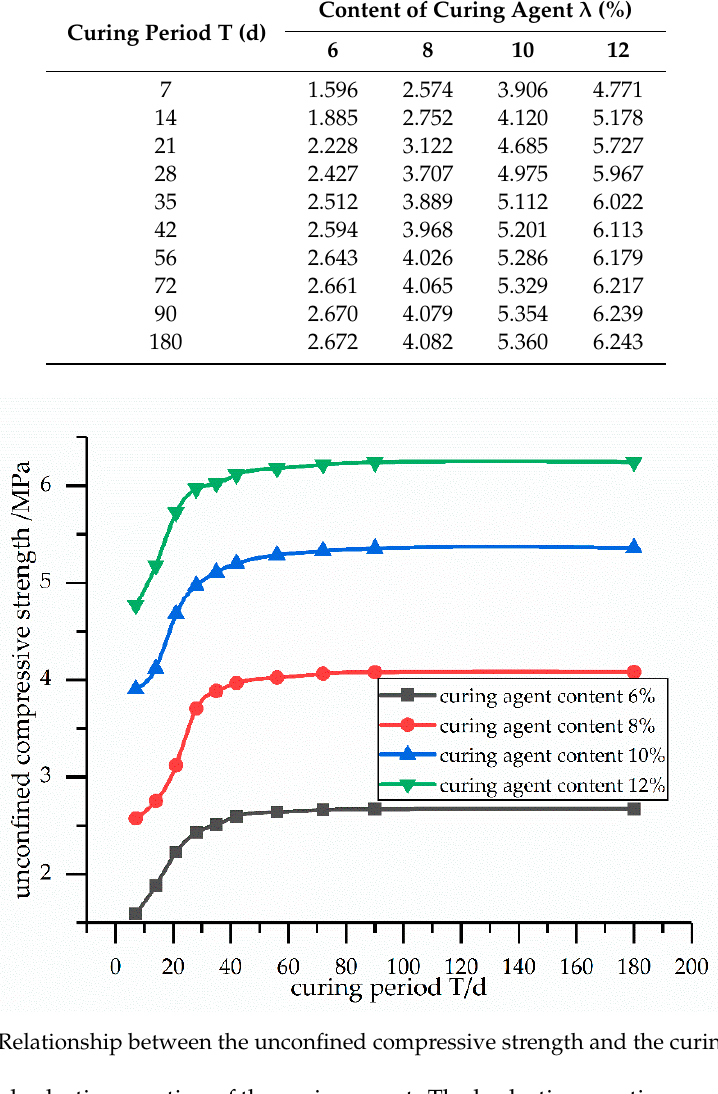
Table 3. The unconfined compressive strength of the solidified calcareous sand (MPa). Curing Period T (d)